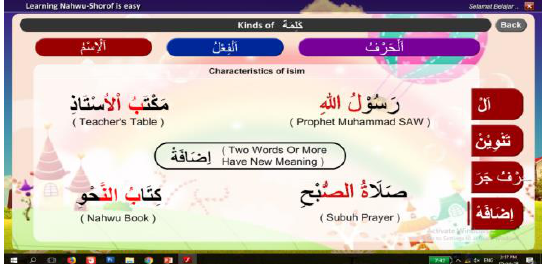
Figure 2. Arabic writing before revision